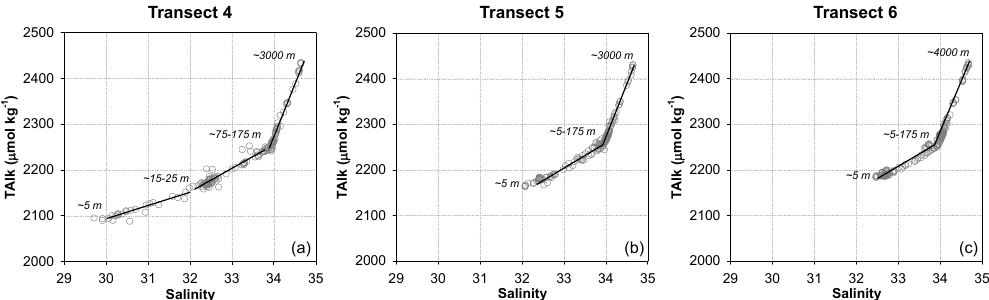
Figure 2. Total alkalinity versus salinity throughout the entire water column of sampling stations along transects 4 (a) , 5 (b) and 6 (c) off Oregon and northern California in spring/early summer 2007. The solid lines indicate various linear relationships observed on each transect. The numbers in italics denote the sampling depth/depth range of the endpoints of each